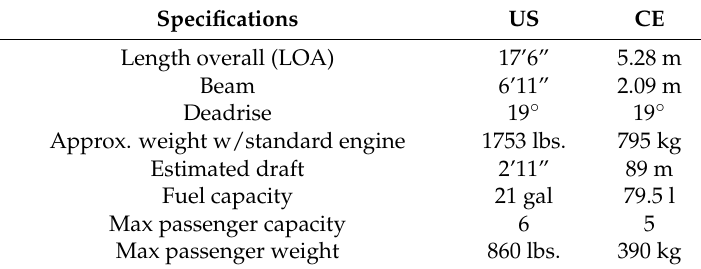
Table A1. Main characteristics of planing